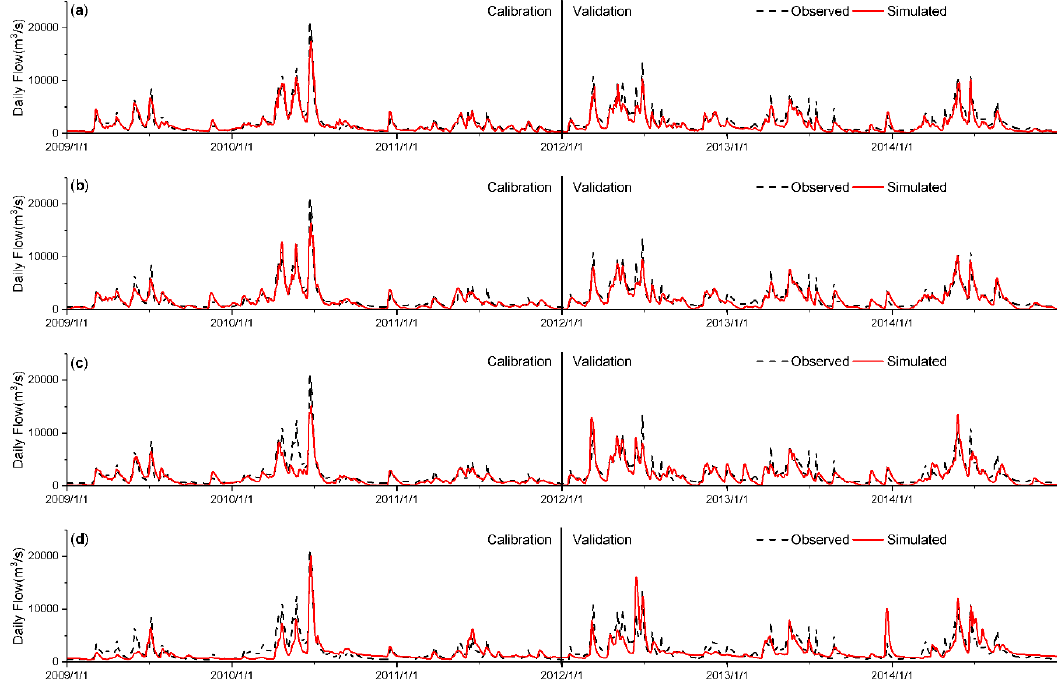
Figure 5. Comparison of daily observed streamflow with SWAT-simulated streamflow driven by ( a )